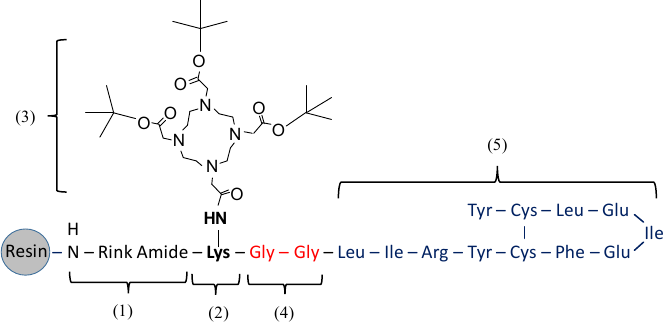
Figure 1. Schematic representation of the assembly of DOTA-OP3-4 by SPPS. Numbered sections indicate the order of assembly. The numbers used refer to: ( 1 ) the attachment of the rink amide linker; ( 2 ) the coupling of Fmoc lys (Mtt)–OH; ( 3 ) the removal of Mtt groups followed by the coupling of